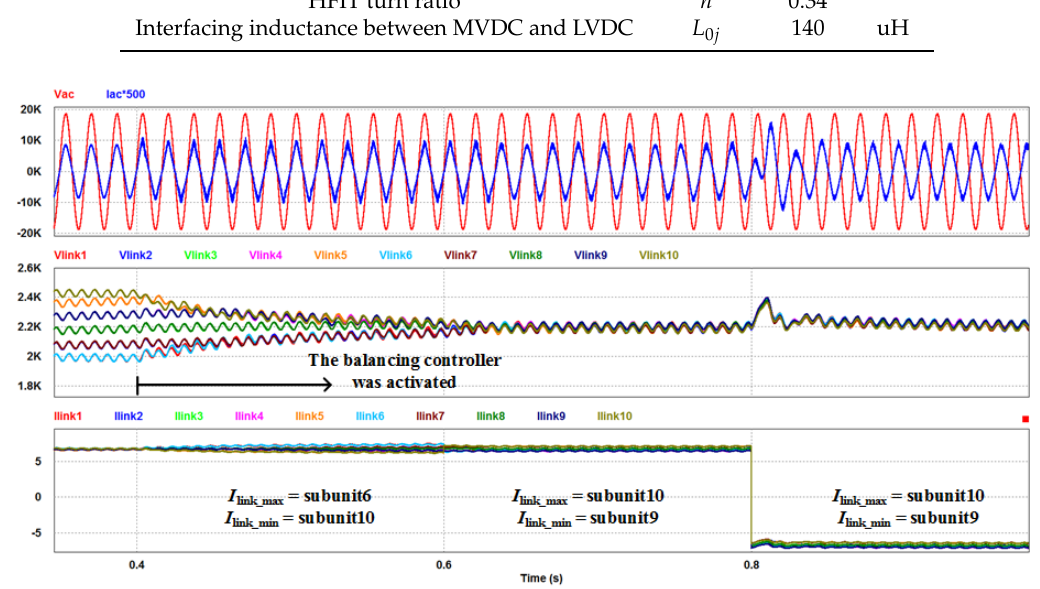
Figure 11. Simulation waveform to verify the voltage balancing capability of the AC/DC stage.